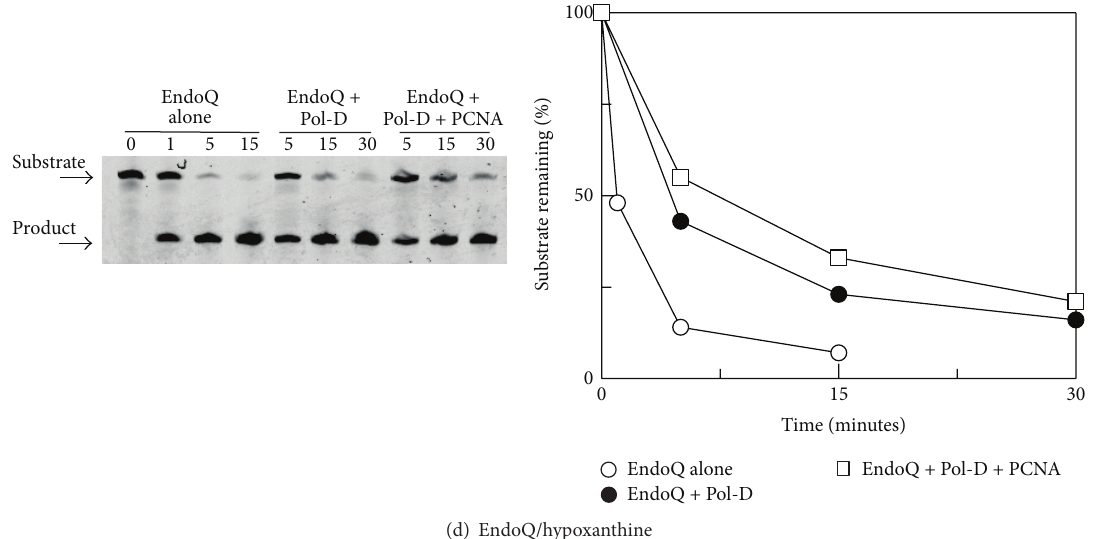
Figure 2: Influence of DNA polymerase-D on the activity of base excision repair enzymes. (a) Inhibition of UDG by Pol-D and Pol-D plus PCNA with uracil. (b) Inhibition of EndoV by Pol-D and Pol-D plus PCNA with hypoxanthine. ((c) and (d)) Inhibition of EndoQ by Pol-D and Pol-D plus PCNA with uracil (c) and hypoxanthine (d). The numbers above the gel lane indicate the hydrolysis time in minutes. In each case a denaturing gel, showing the raw data, and a scan of the gel, showing the substrate remaining with time, are given. In these experiments Pol-D exo − (H445A) was used. These experiments were repeated four times and very similar inhibition was seen in every case. The data points in the scans have an error of < 15%.